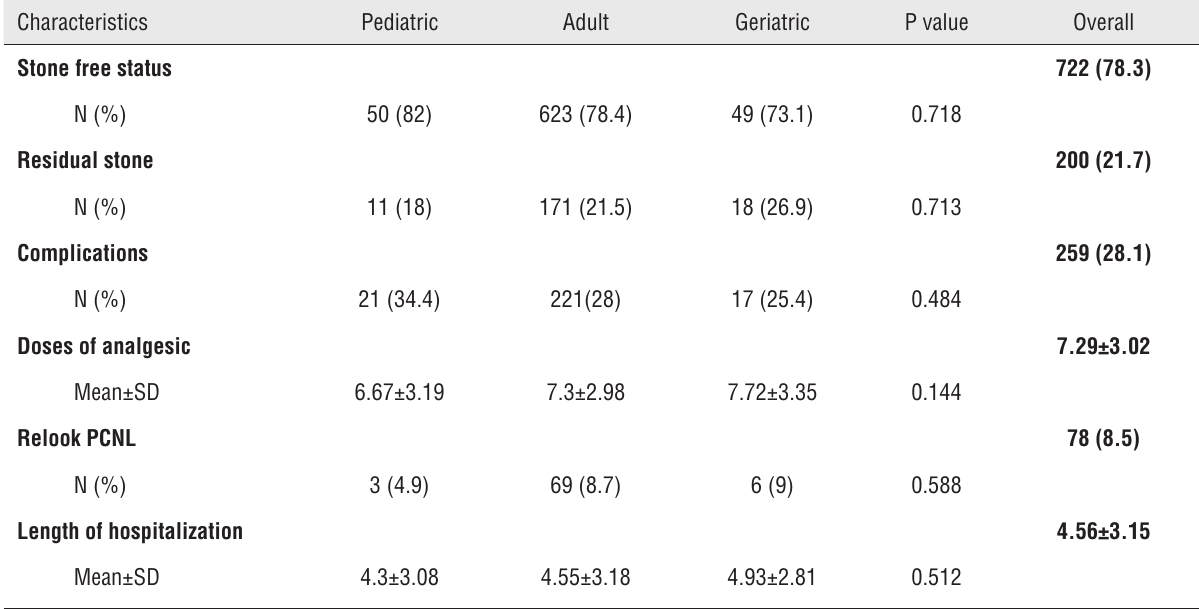
Table 4 - Outcomes – overall and among three age